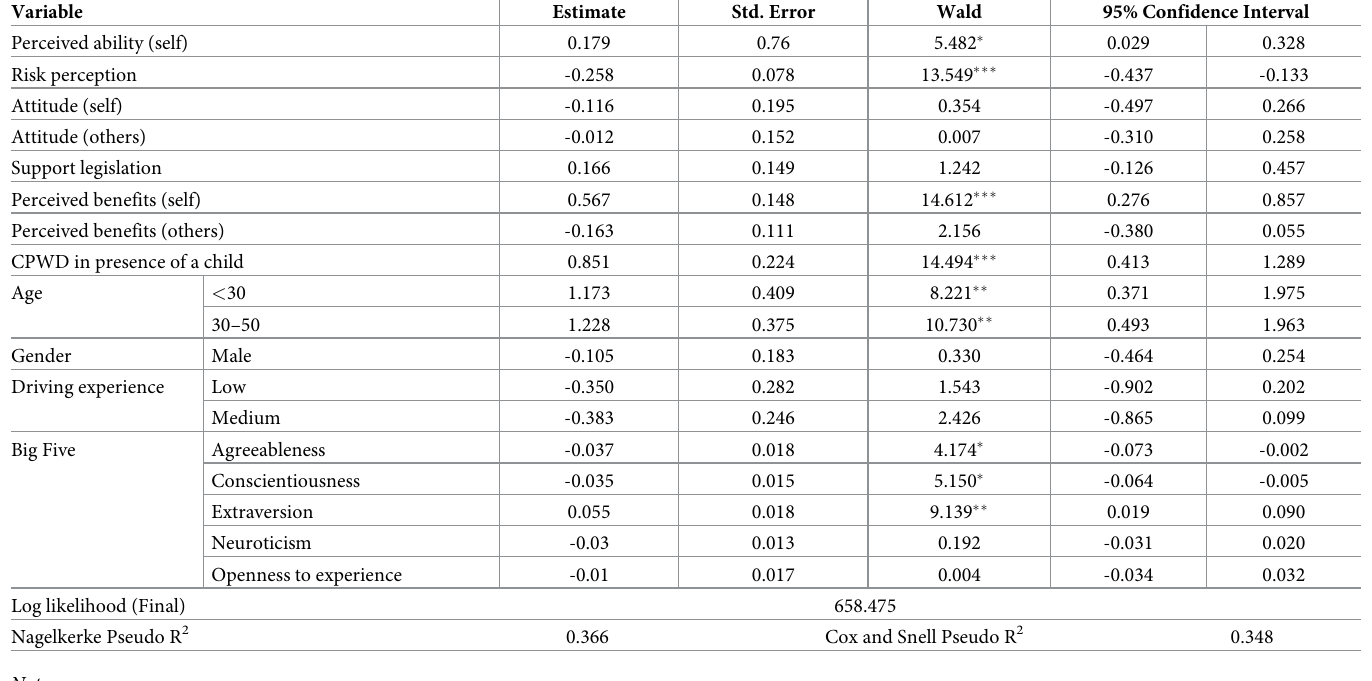
Table 5. Factors related to the frequency of